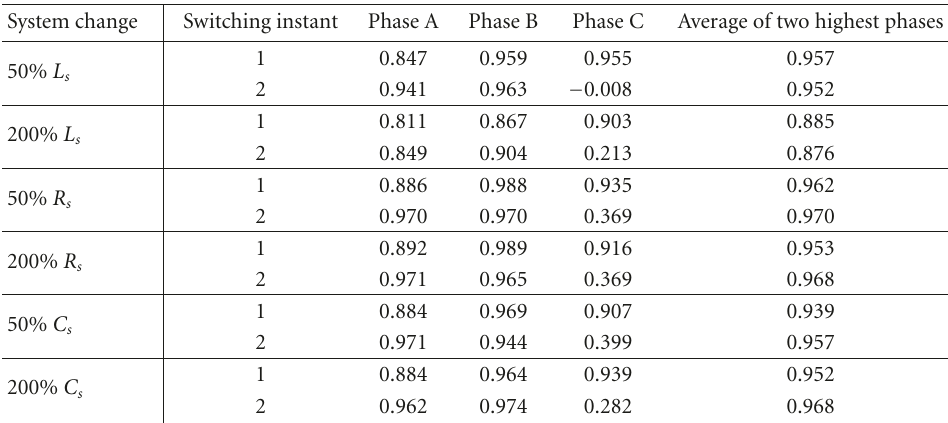
Table 4: Results with changes to system parameters.